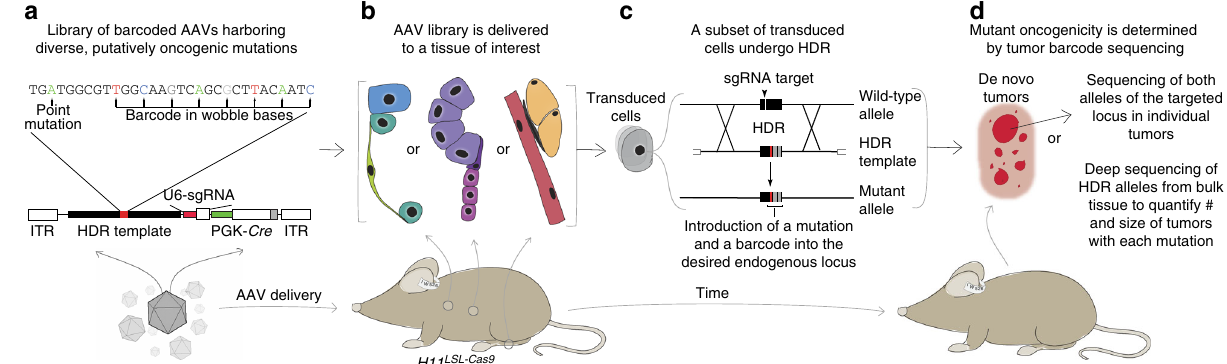
Fig. 1 A cancer modeling platform that integrates AAV/Cas9-mediated somatic HDR with tumor barcoding and sequencing to enable the rapid introduction and functional investigation of putative oncogenic point mutations in vivo. a – d Schematic of the pipeline to quantitatively measure the in vivo oncogenicity of a panel of de fi ned point mutations. a A library of AAV vectors is generated such that each AAV contains: (1) a template for homology- directed repair (HDR) containing a putatively oncogenic point mutation and a random DNA barcode encoded in the adjacent wobble bases; (2) an sgRNA targeting the desired endogenous locus to enhance HDR; and (3) Cre -recombinase to activate a conditional Cas9 allele ( H11 LSL-Cas9 ) and other Cre- dependent alleles in genetically engineered mice. b The AAV library is delivered to a tissue of interest. c Following transduction, a subset of cells undergo AAV/Cas9-mediated HDR in which the locus of interest is cleaved by Cas9 at the sgRNA target site and repaired using the AAV HDR template. This results in the introduction of the desired point mutation and a unique DNA barcode at the targeted locus. d Somatic cells engineered with a point mutation may develop into de novo tumors if the introduced mutation is suf fi cient to initiate tumorigenesis and drive tumor growth. Two independent approaches can be used to analyze tumors: (1) the targeted region in individual tumors can be sequenced to characterize both alleles of the targeted gene, or (2) next- generation sequencing of the targeted region can be used to determine the number, size, and genotype of each tumor directly from bulk tissue in